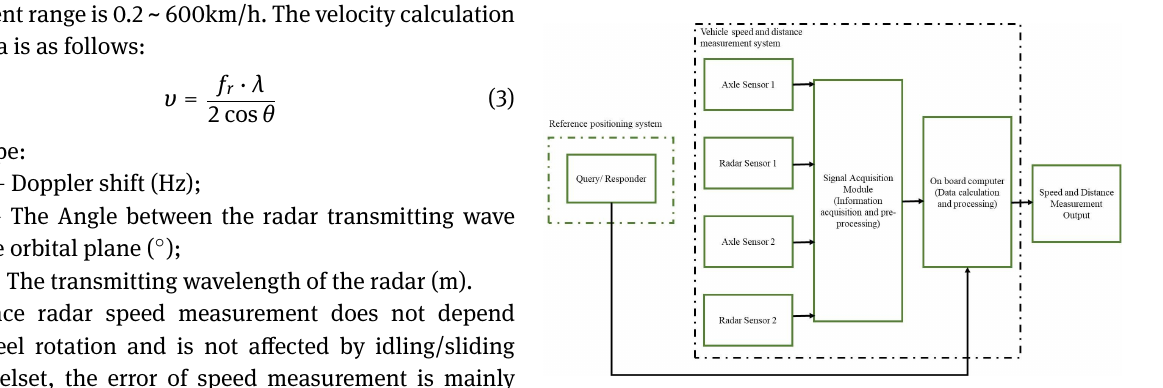
Figure 2: Hardware structure of velocity measurement and ranging